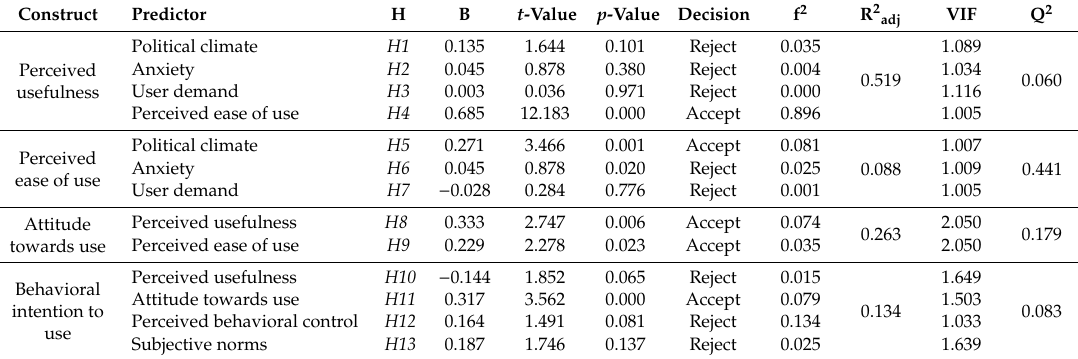
Table 8. Path Coe ffi cients and model quality assessment (for RWHS with WTS).